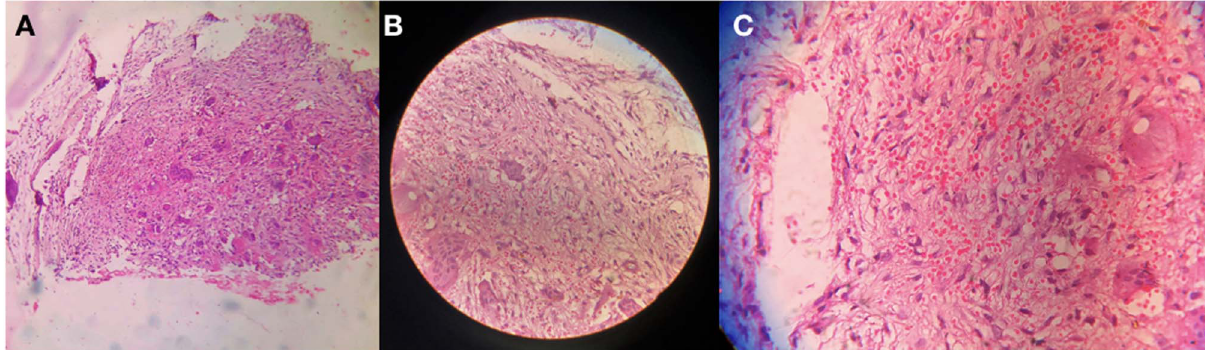
Figure 4. Hematoxylin and eosin-stained slide, scanner view showing Cystic spaces surrounded by fi brous tissue proliferation along with multiple osteoclastic giant cells at 4 (cid:1) magni fi cation (A). 10 (cid:1) magni fi cation (B) and 40 (cid:1) magni fi cation (C) showing cystic spaces fi lled with few rbcs lined by bland fi broblast and dense fabricollagenous tissue in the surrounding with proliferating capillaries and numerous osteoclastic giant cells.